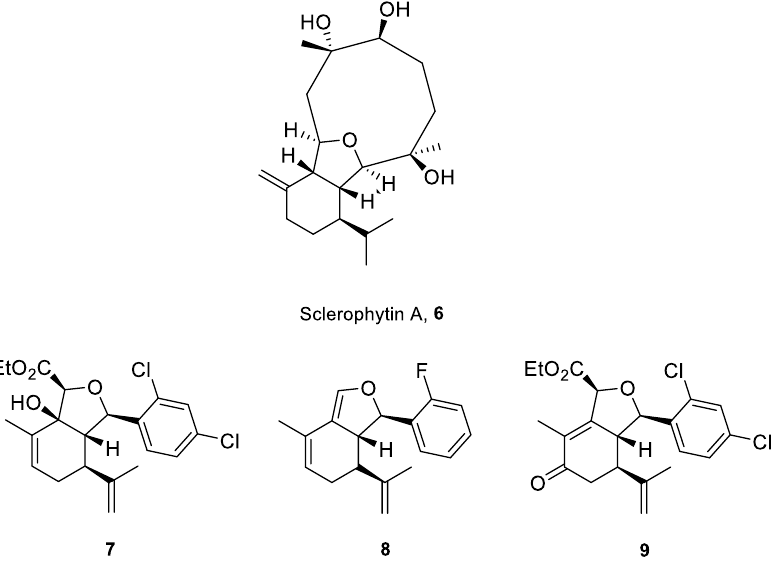
Figure 4. The most active analogues of sclerophytin A 6 exhibited anticancer activity.